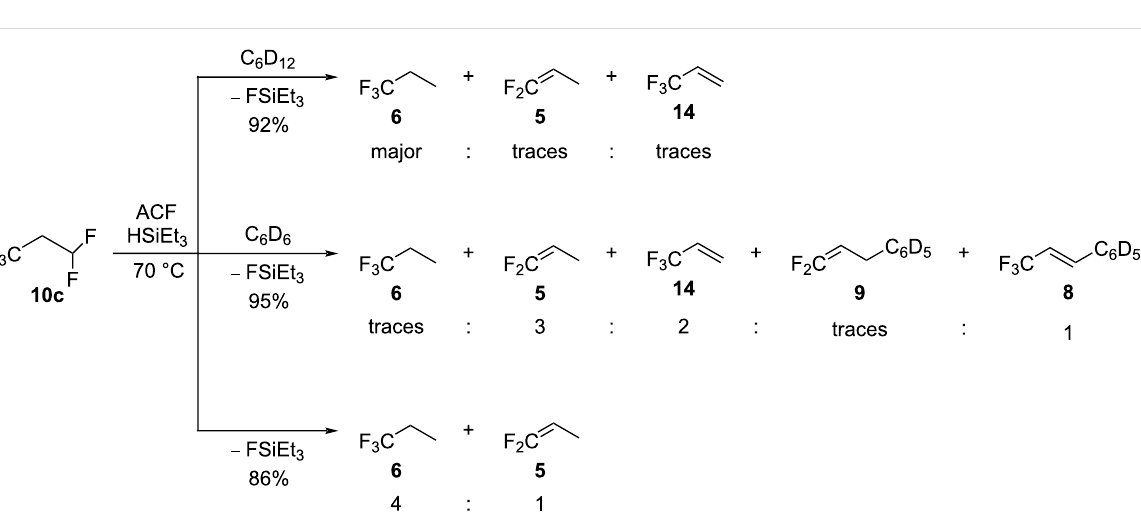
Scheme 11: Reactivity of 10c in the presence of ACF as the catalyst and HSiEt 3 as a hydrogen source in C 6 D 12 (top) or C 6 D 6 (middle) as solvents or in neat silane